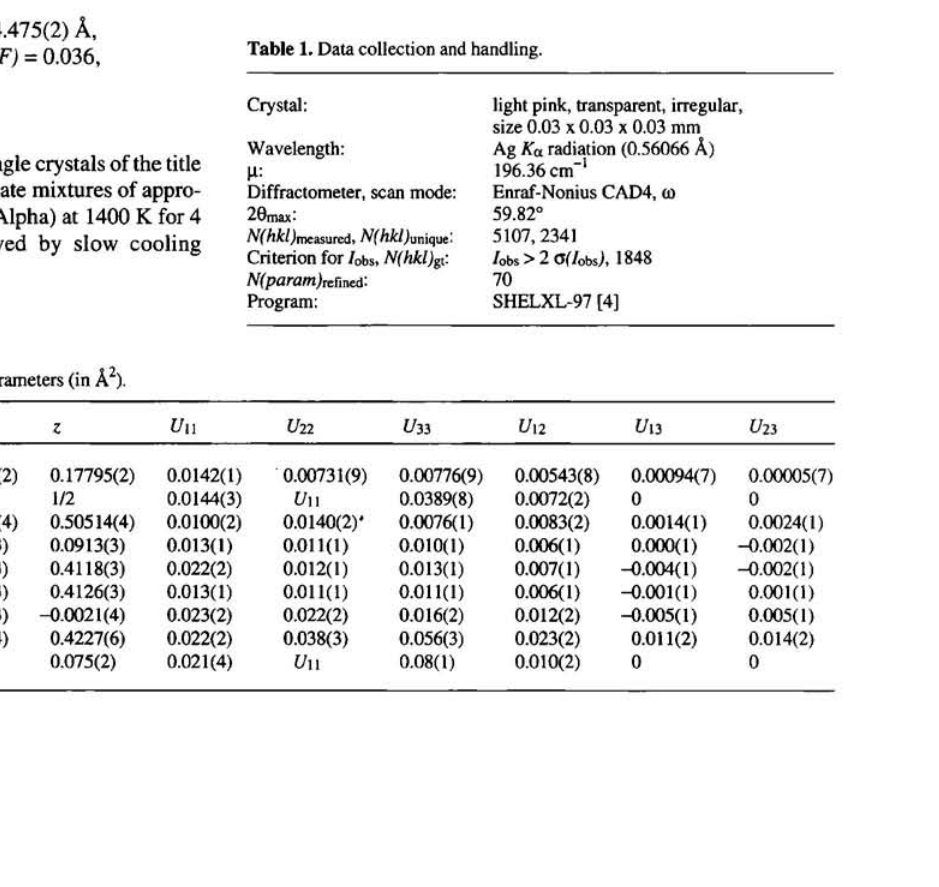
Table 2. Atomic coordinates and displacement parameters (in Â 2